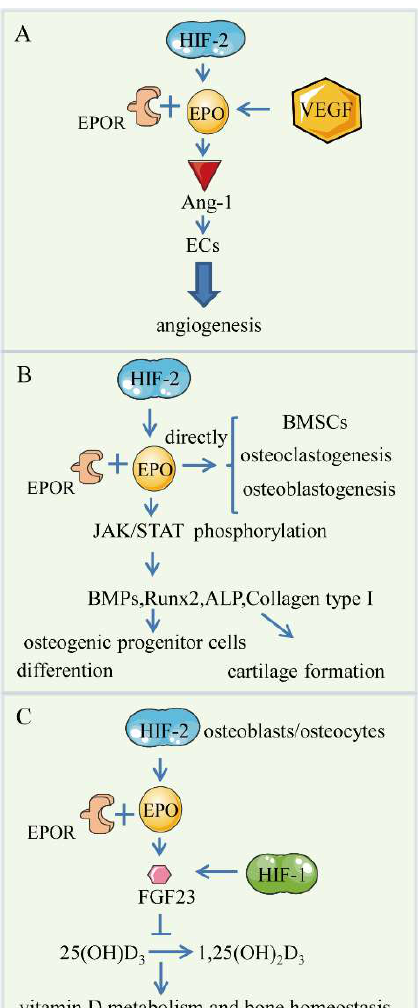
Figure 3. HIFs/EPO pathway. ( A ) Bone angiogenesis. HIF-2 can increase EPO production to up- regulate Ang-1 to promote angiogenesis. VEGF is a potent EPO inducer. ( B ) EPO phosphorylates the JAK/STAT signal transduction cascade in cells and induces differentiation of osteoblast progenitors and chondrogenesis. EPO can directly promote the differentiation of BMSCs and osteoclastogenesis and osteoblastogenesis. ( C ) HIF-2/EPO/FGF23 pathway. HIF-2 induces the production of EPO to regulate the regulation of calcium and phosphate metabolism on bone mineralization. FGF23 is also directly regulated by HIF-1.